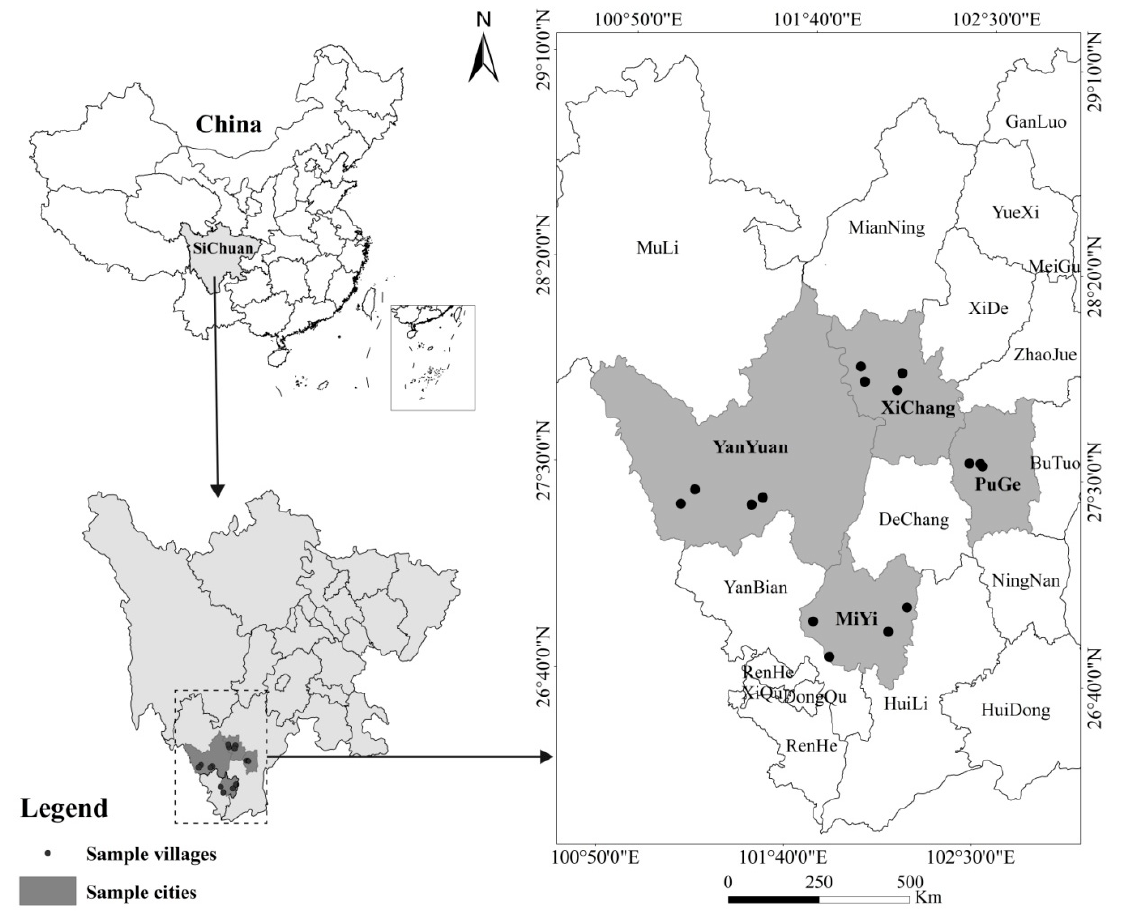
Figure 1. Location of sample cities and villages.